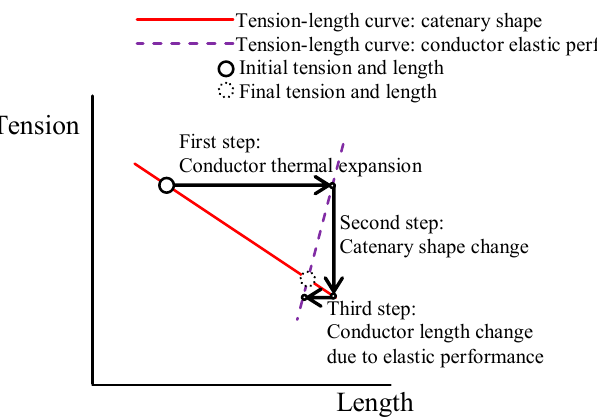
Figure 2. Conductor tension and length change due to the conductor temperature change.